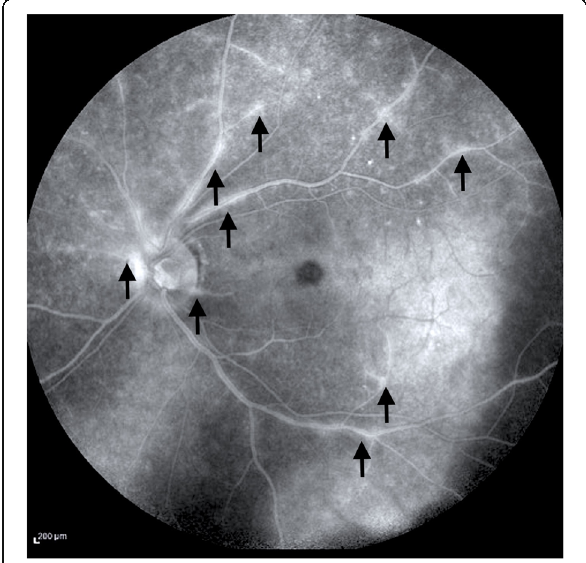
Fig. 3 Fundus fluorescein angiography in a case of tertiary syphilis, revealing segmental leakage typical of retinal vasculitis (black